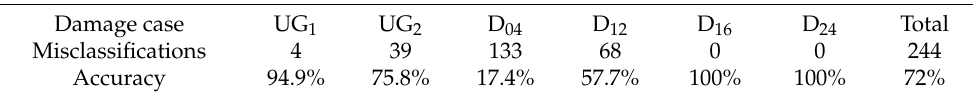
Table 9. Accuracy and number of misclassifications of the improved algorithm (BFC for feature extraction, RELIEFF for feature selection, SVM with RBF kernel for classification validated with LOGOCV) for the combination of transducers 1 (sender) and 7 (receiver). Validation Results of the Improved Algorithm for the Combination of Transducers 1 and 7